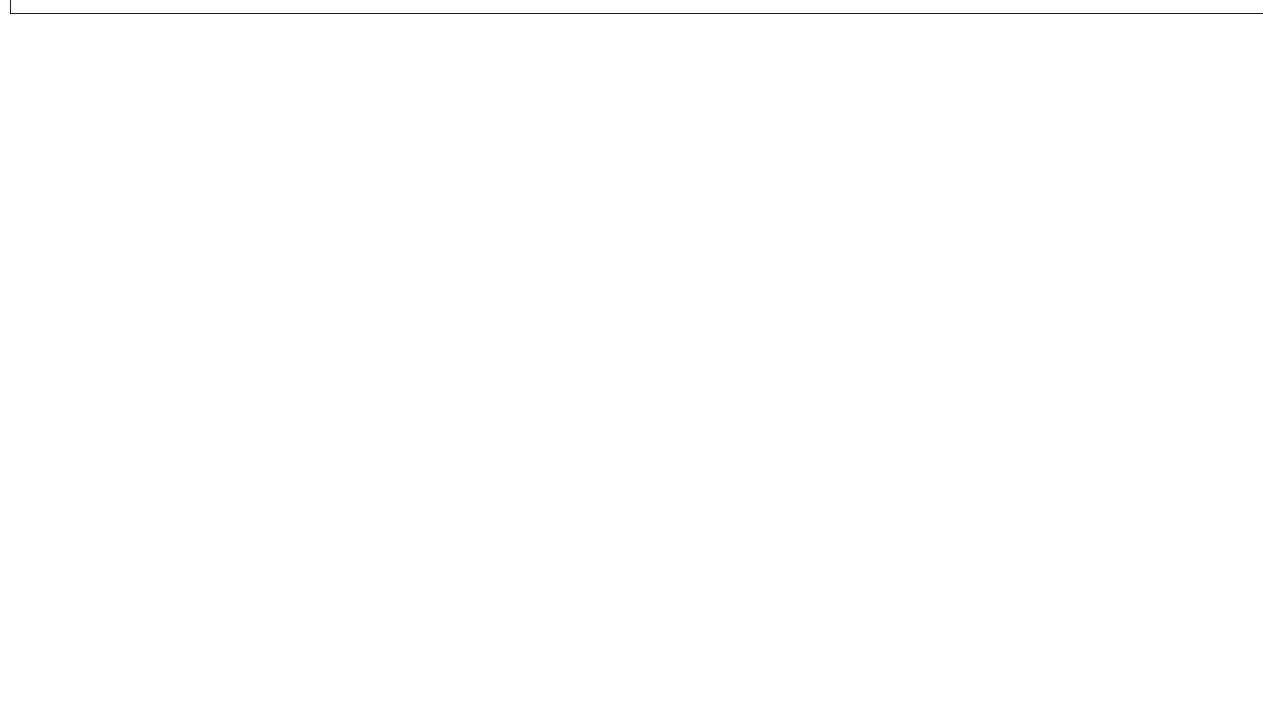
FIGURE 3 | Plasma levels and activity of ACE, ACE2, and NEP in non-pregnant (NP) and pregnant women (A–D) . Plasma levels of Ang-(1-7) were measured by radioimmunoassay in NP and pregnant women (E) . Plasma ACE2/ACE ratio and ACE2 activity/ACE ratio in NP and pregnant women (F,G) . Data are expressed as median and interquartile range. n = 9–10 samples for the NP group (black box), n = 7–35 samples/group for 13, 18, 30, and 36 weeks of normal pregnancy (white box). P -values were calculated using a Kruskal–Wallis test (with Dunn’s multiple comparison test). * P < 0.05, ** P < 0.01, *** P < 0.001 versus